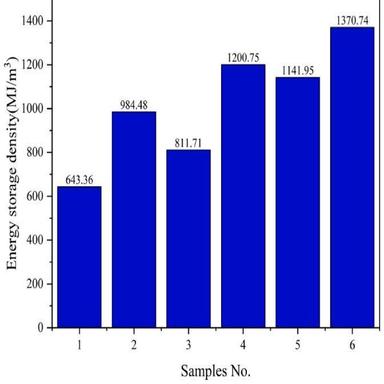
TES densities of BS and CPCMs.